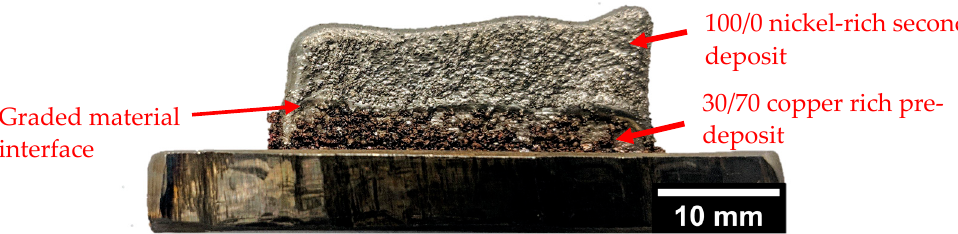
Figure 9. Copper–nickel FGM deposit fabricated with 30/70 as the pre-deposit and 100/0 as the second deposit. The set 3 duty cycle rampdown parameter was used at the dissimilar material interface.